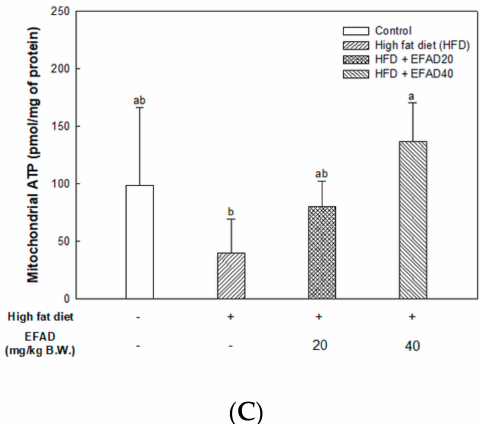
Figure 6. E ff ect of ethyl acetate fraction from Aruncus dioicus var. kamtschaticus (EFAD) on mitochondrial dysfunction induced by HFD in brain tissue of mice. ( A ) Mitochondrial membrane potential (MMP). ( B ) Degree of ROS levels in mitochondria. ( C ) Mitochondrial ATP levels. The values shown are as mean ± SD ( n = 5). The data were statistically considered at p < 0.05 and were represented as di ff erent small letters.